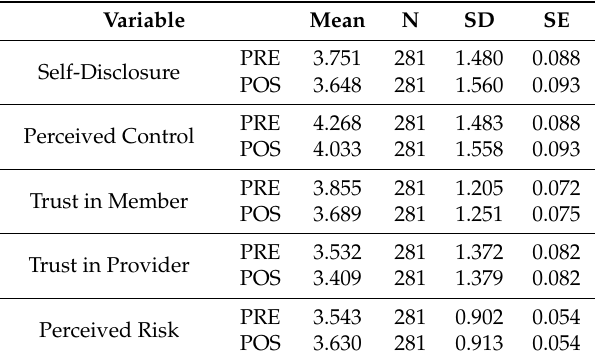
Table 3. Paired samples statistics.